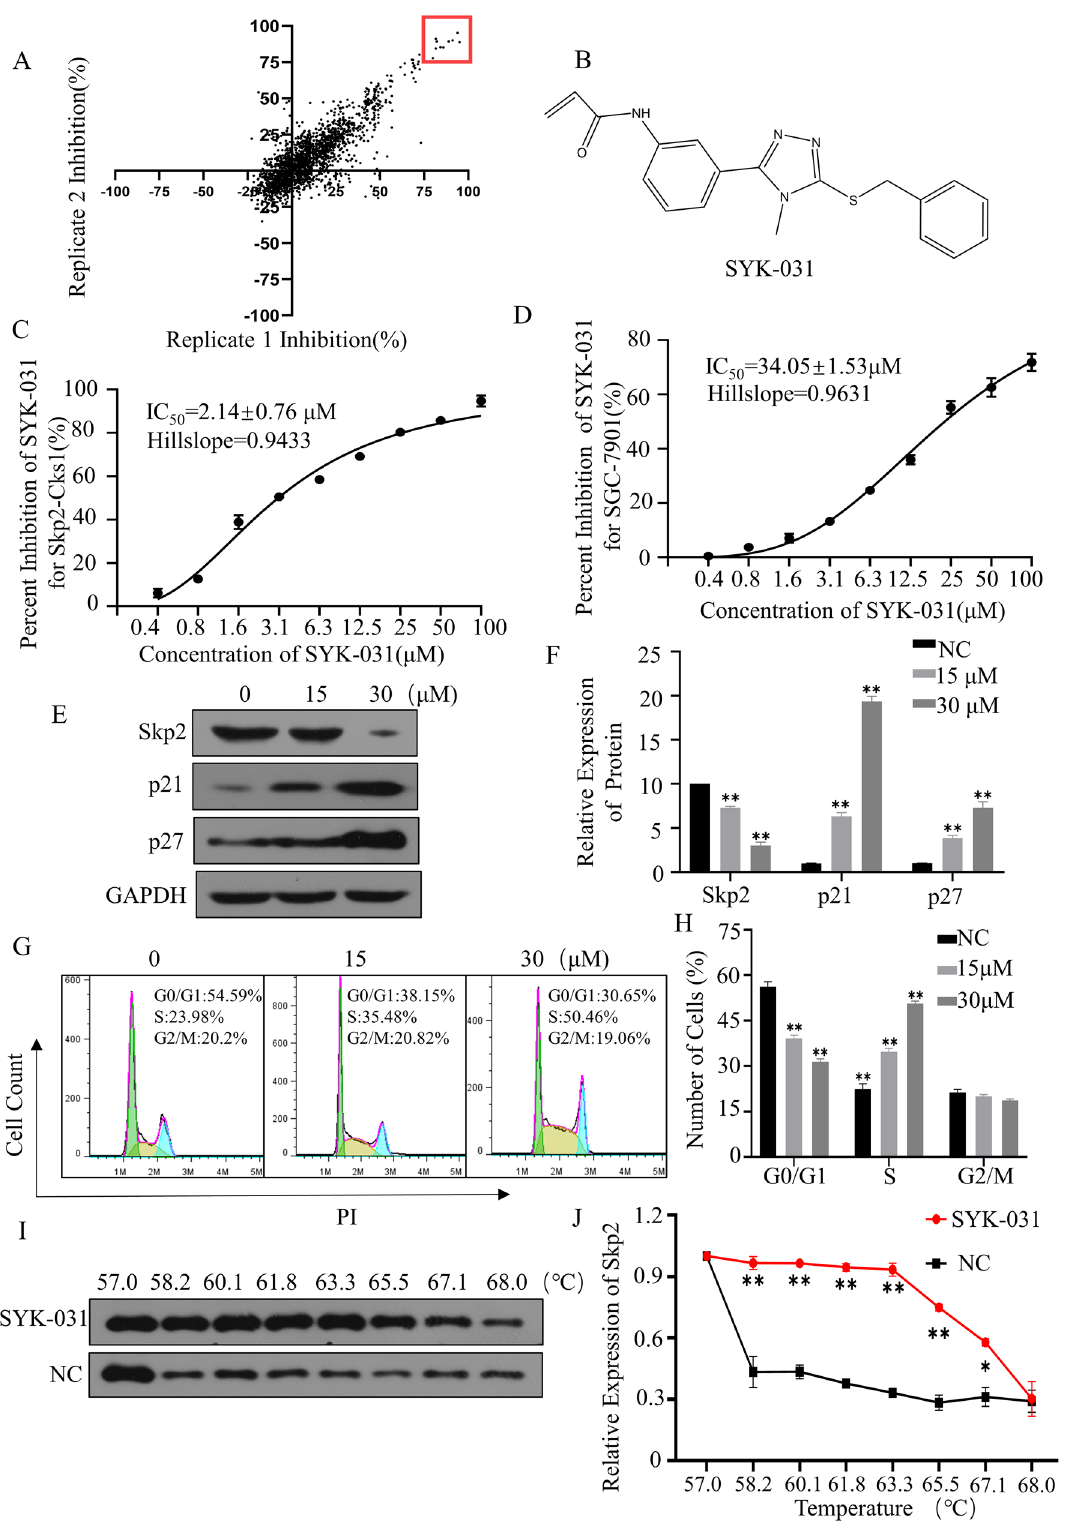
Figure 6. Discovery and bioactivity evaluation of compound SYK-031. ( A ) percent inhibition of 2118 compounds at 50 μM for Skp2-Cks1. ( B ) The chemical structure of compound SYK-031. ( C ) The percent inhibition of the compound SYK-031 at various concentrations in Skp2-Cks1. ( D ) The percent inhibition of the compound SYK-031 at various concentrations in SGC-7901. ( E , F ) SGC-7901 cells treated with increasing concentrations of SYK-031 for 48 h and the cells lysates were collected for Western blotting with the indicated antibodies. ( G , H ) SGC-7901 cells treated with increasing concentrations of SYK-031 for 48 h. Fixed cells were collected and the cell cycle was measured by flow cytometry. ( I , J ) SGC-7901 cells treated with 50 μM SYK-031 for 4 h, the stability of protein Skp2 was measured at different temperatures. The representative data of at least three independent experiments are shown, * P < 0.05, ** P < 0.01. compared with the control group (mean ± SD, n =